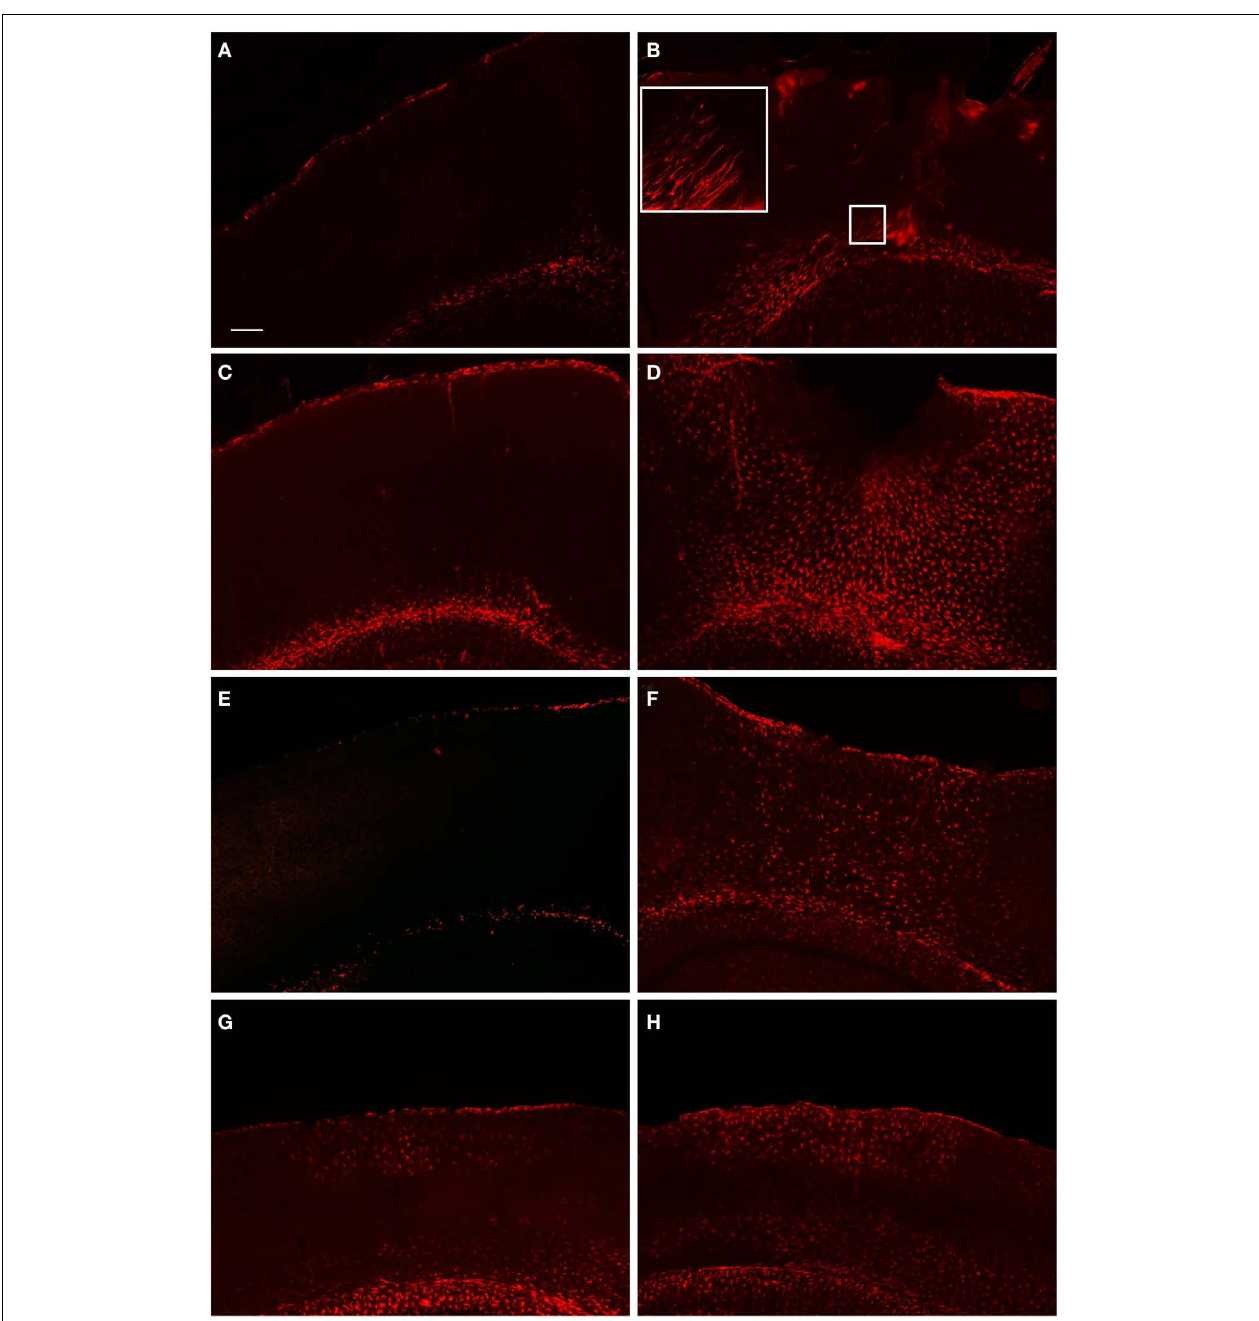
in the peri-lesion area (D) . Only minimal GFAP-labeling is observed in the contralateral hemisphere at this timepoint (C) . At 7days post-FPI (E,F) , the appearance of GFAP-labeled astrocytes with an activated appearance is decreased relative to the 3-day timepoint. In the corresponding contralateral hemisphere at 7days post-FPI, there appears to be diminished GFAP-labeling relative to 1 and 3days, as well as sham and naïve mice (data not shown). At 30days post-FPI (G,H) , a sizable population of GFAP-labeled astrocytes is observed in both the contralateral (G) and ipsilateral (H) hemispheres. In both hemispheres, the labeling is quite robust in layers I–IV andVI, but conspicuously absent in layerV. Scale bar in (A) = 50 µ m for all